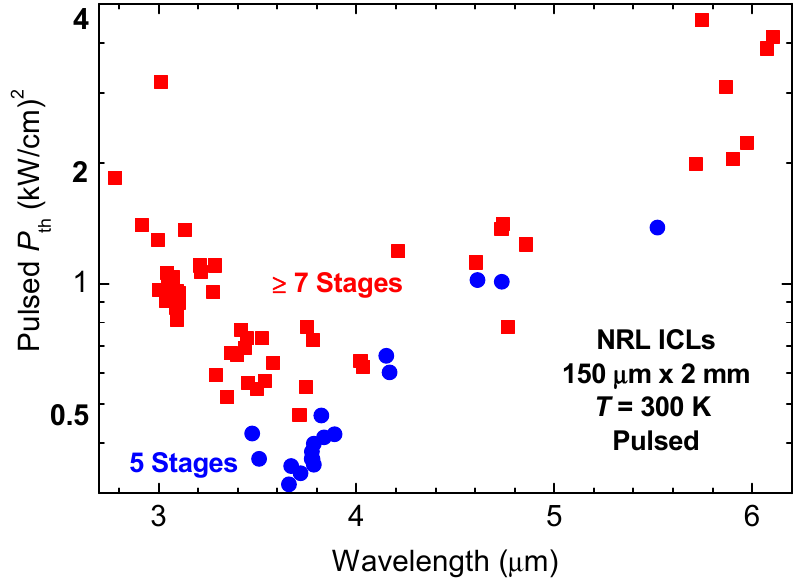
Figure 5. Pulsed threshold power densities at T = 300 K as a function of wavelength for the same NRL broad-area ICLs as in Figure 4. Devices with 5 stages are represented by blue points and those with 7 or more stages by red points.